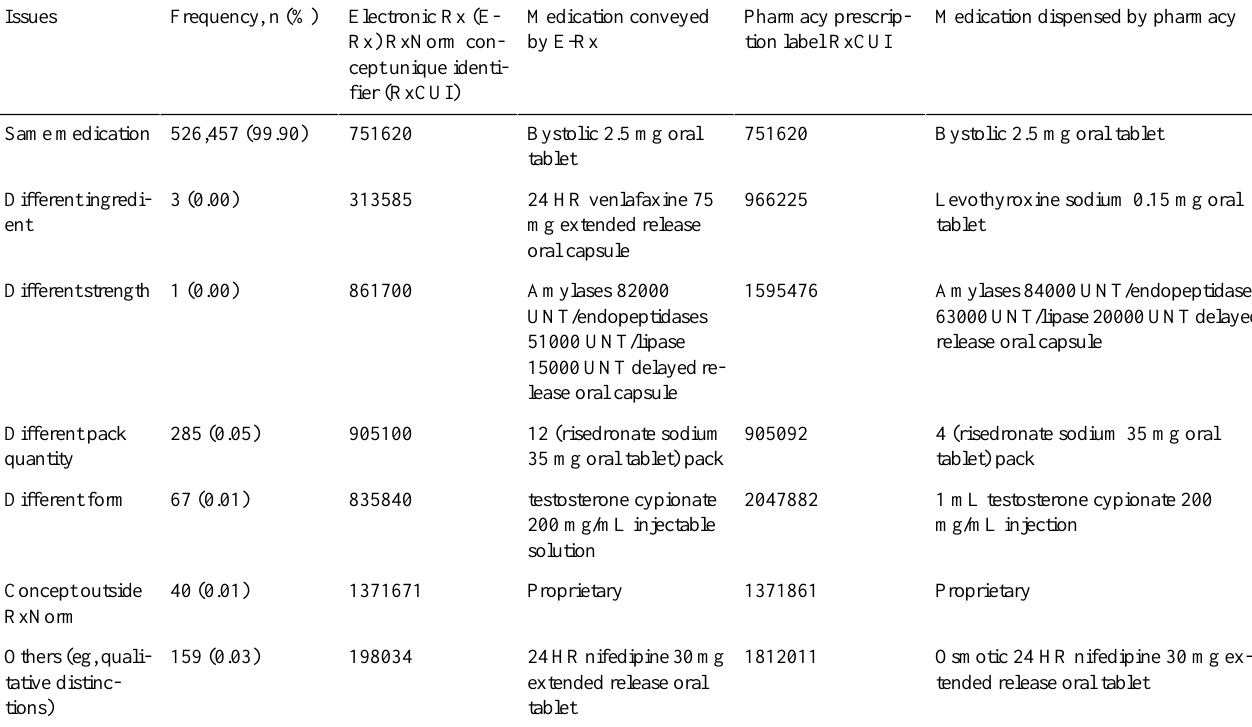
Table 3. Performance evaluation of the algorithm for detecting different medication selection, with examples